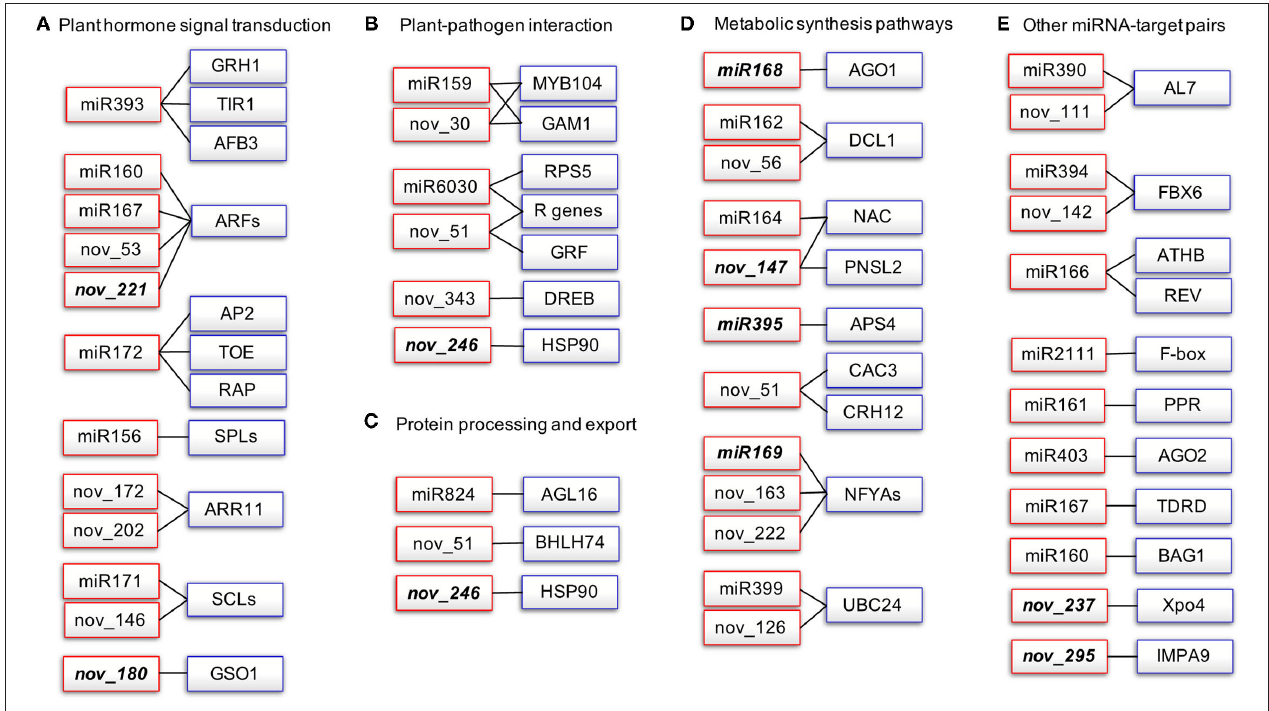
FIGURE 4 | Network of degradome validated miRNA-target pairs associated with P. brassicae response in B. napus . Red rectangles represent the miRNAs and blue rectangles represent the target transcripts validated by degradome sequencing. Italics indicate miRNAs that are significantly differentially expressed after P. brassicae infection. AFB, auxin signaling F-box; AGO1, argonaute1; AP2, apetala2; APS, ATP sulfurylase; ARF, auxin response factor; MYB, myeloblastosis; NFYA, nuclear transcription factor Y subunit alpha; AGL, agamous-like MADS-box protein; AL7, PHD finger protein ALFIN-LIKE 7-like; BAG1. BAG family molecular chaperone regulator 1-like; CAC3, acetyl-coenzyme A carboxylase carboxyl transferase subunit alpha; DCL1, endoribonuclease Dicer homolog 1; DREB, dehydration-responsive element-binding protein 2B-like; FBX6, F-box only protein 6; GRF, growth-regulating factor; HSP90, heat shock protein 90-2-like; PNSL2, photosynthetic